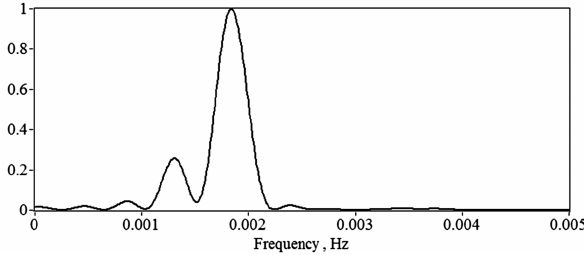
Figure 9. Normalised spectrum of the wave addend of wind velocity calculated from the data shown by the solid curve in Fig.